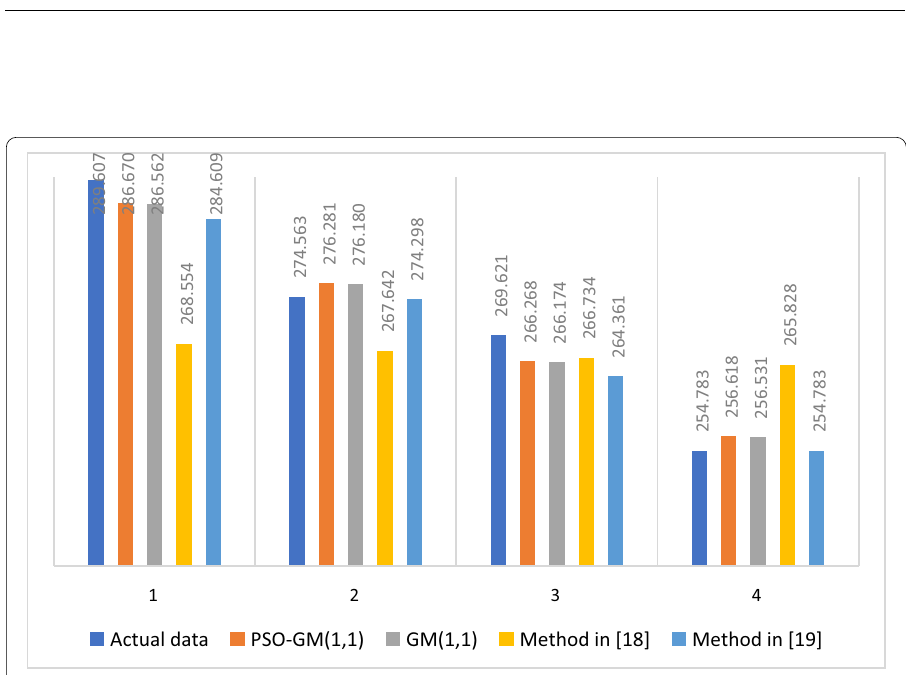
Fig. 7 Forecast results for energy data for a photocopier, using the various